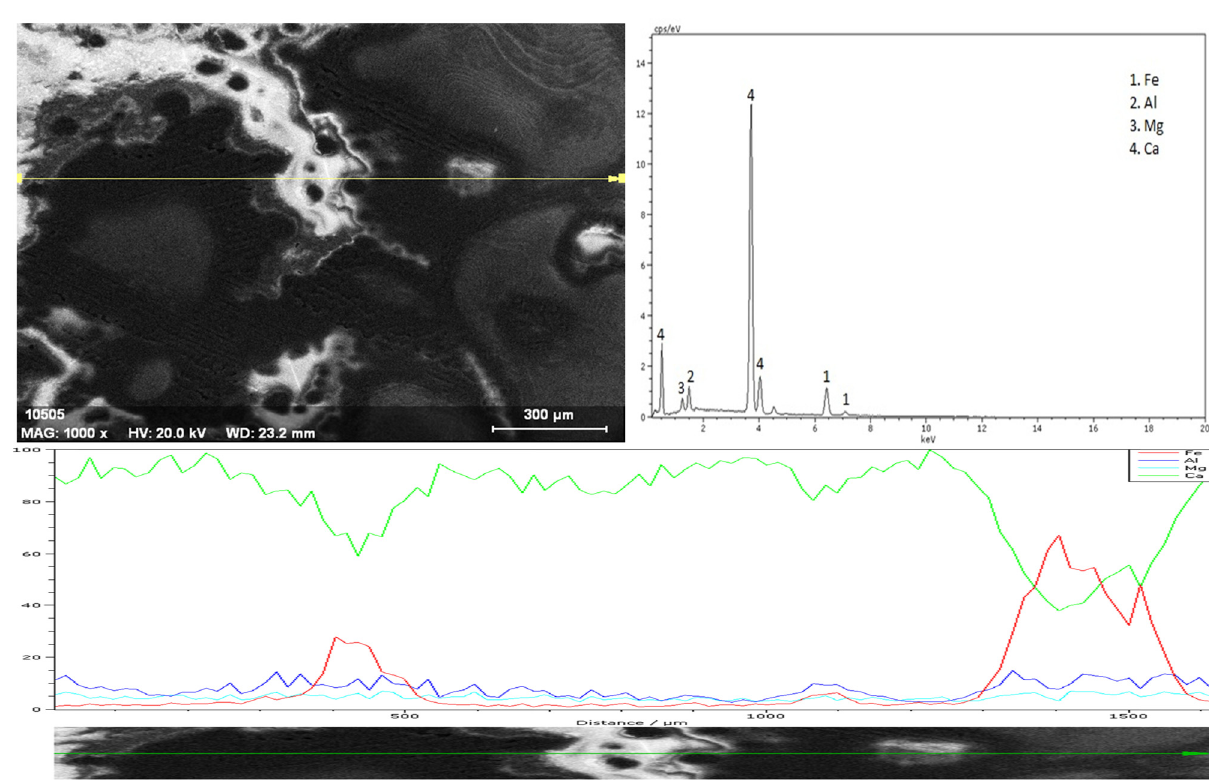
Figure 9: EDX analysis of Fe – B 4 C – 6.66% egg